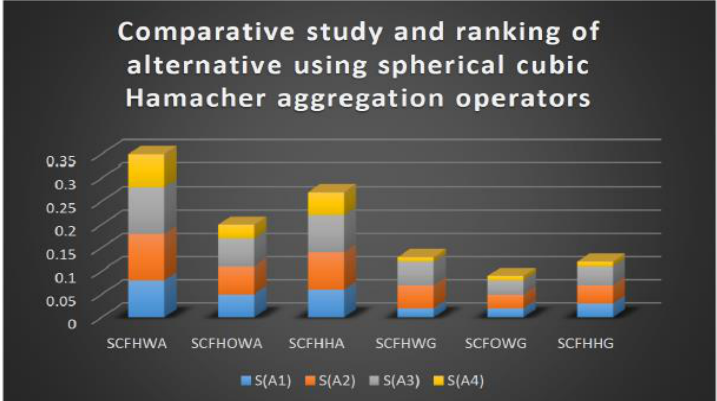
Figure 1. Comparison study and ranking of alternatives. SCFHWA: spherical cubic fuzzy Hamacher weighted average, SCFHOWA: spherical cubic fuzzy Hamacher ordered weighted average, SCFHHA: spherical cubic fuzzy Hamacher hybrid average, SCFHWG: spherical cubic fuzzy Hamacher weighted geometric, SCFHOWG: spherical cubic fuzzy Hamacher ordered weighted geometric, SCFHHG: spherical cubic fuzzy Hamacher hybrid geometric. Mathematics 2020 , 8 , x FOR PEER REVIEW